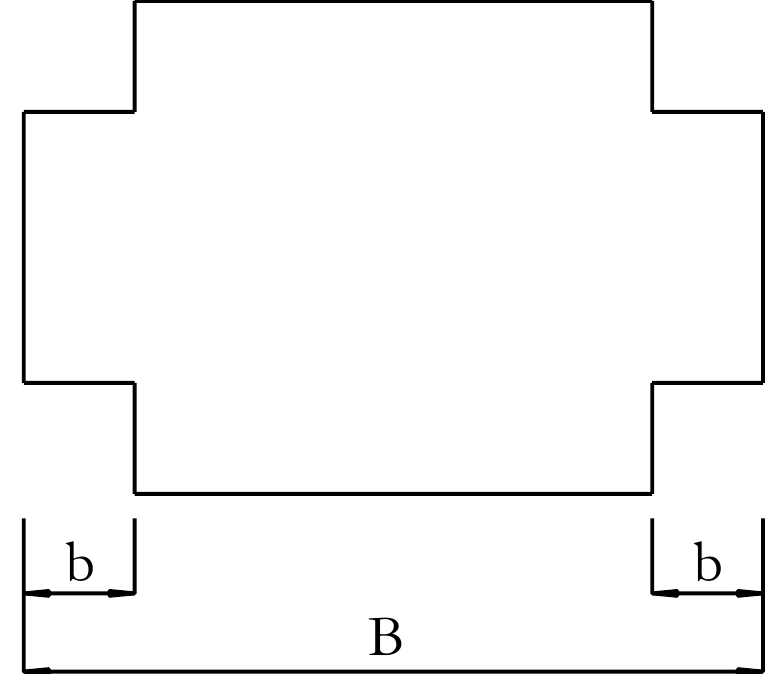
Figure 6. The definition of corner set − back (top view).